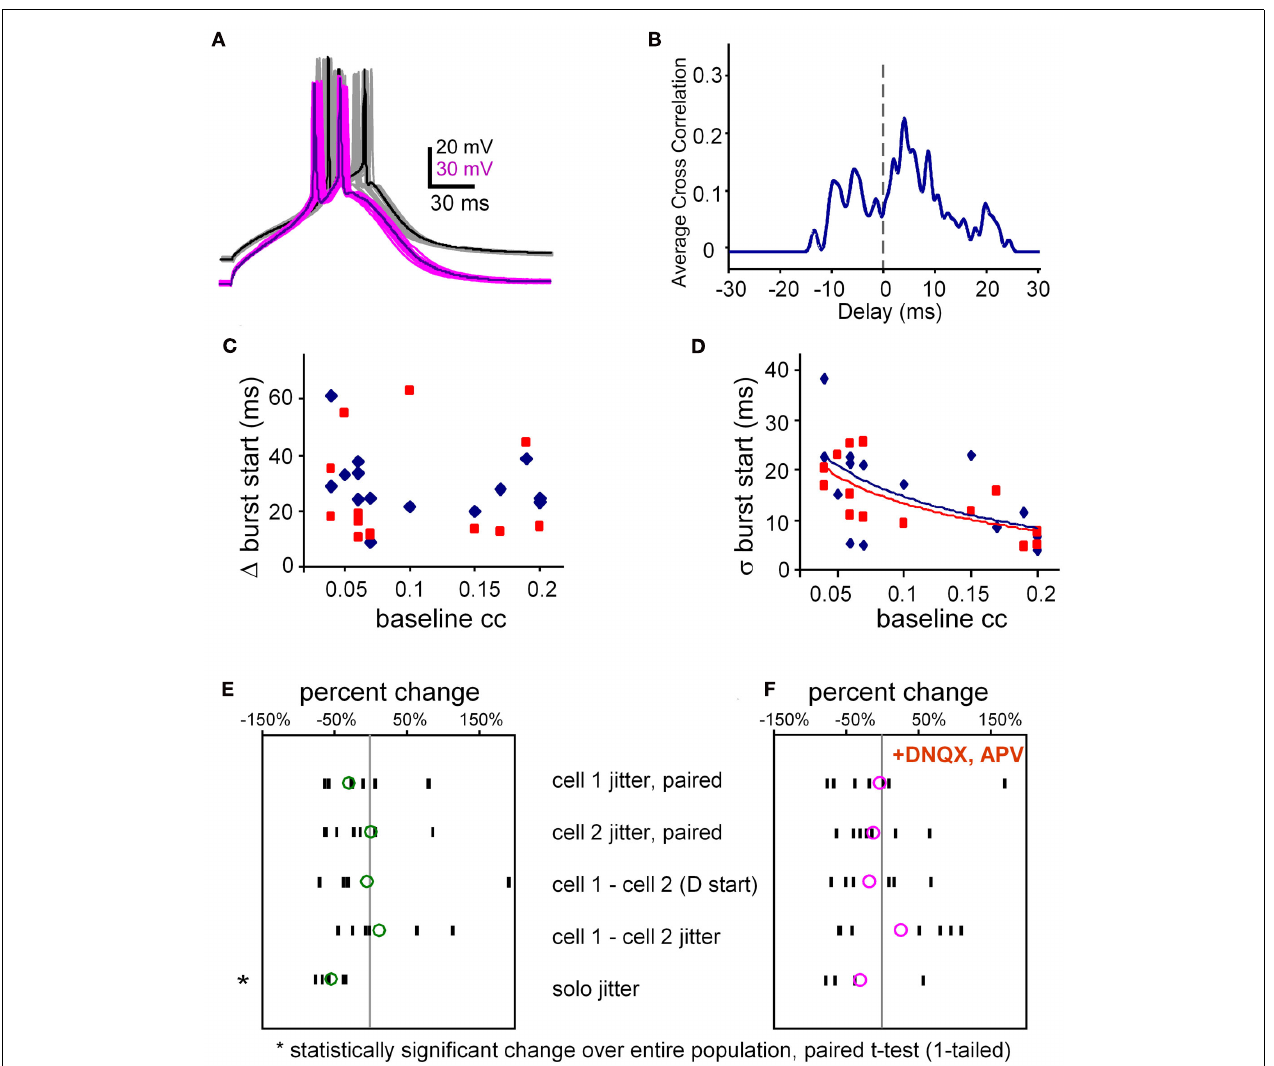
FIGUREA2 | Burst jitter. (A) Example of 16 overlaid trials of aligned bursts from a pair of electrically coupled neurons. Note that even though their slow depolarizations (calcium spikes) are aligned, their spikes are rarely aligned. Average coupling coefficient at V rest , was 0.14. (B) Spike cross-correlogram for data shown in (A) . Spikes were represented by Hanning windows, 2ms-wide. Cross correlation was done at the same temporal resolution as the data, 0.05ms. (C) Burst synchrony ( Δ burst start times, y -axis) is uncorrelated with electrical synaptic coupling strength ( x -axis; R 2 = 0.06) in both ACSF (blue symbols) and inTTX ( R 2 = 0.01, red symbols, N = 14 pairs). (D) A reduction in the jitter of burst synchrony (SD of the absolute difference in onset times) is